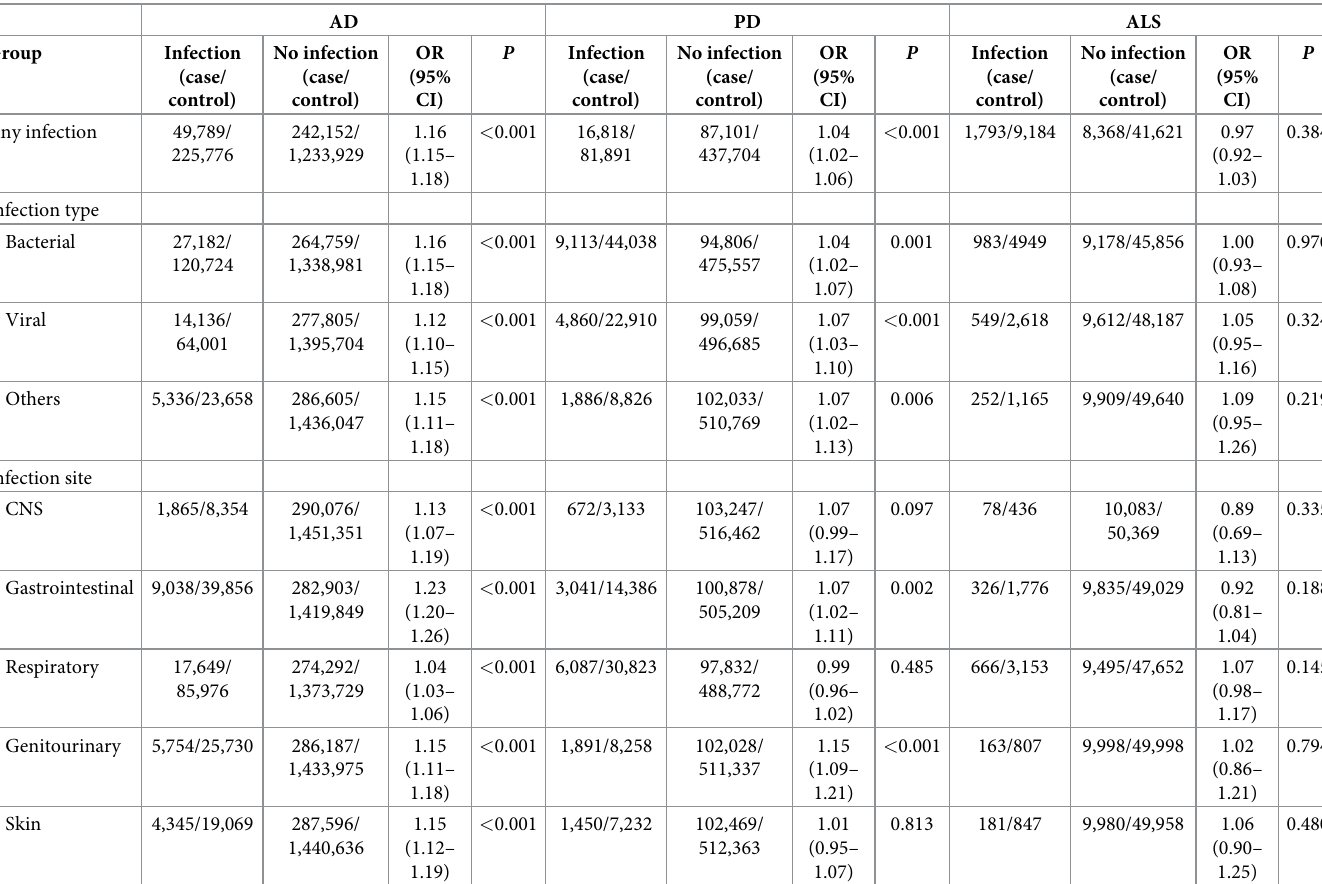
Table 2. Association between hospital-treated infection and risk of neurodegenerative disease.